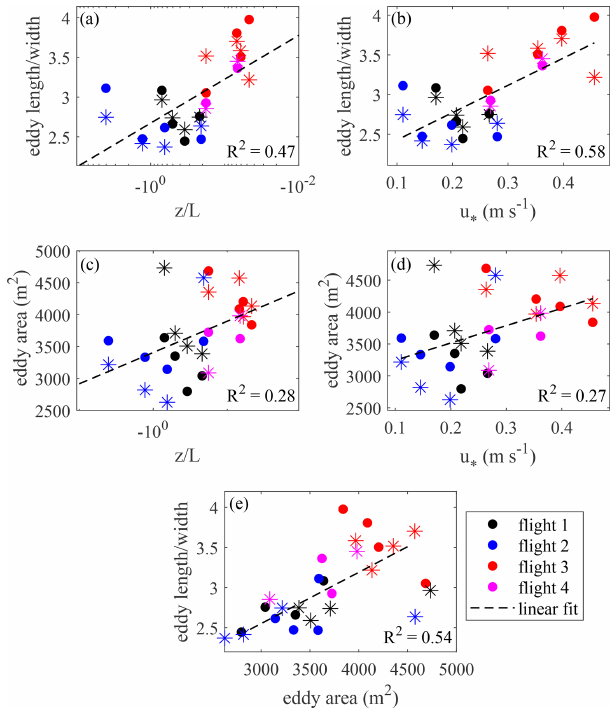
Figure 12. (a–d) Relationship between the 5min average properties of eddy thermal traces (mean area, length-to-width ratio) and the corresponding averages of z/L O and u ∗ ; (e) length-to-width ratio versus mean area. The * indicates eddy traces with positive mean T (cid:48) ; • indicates those with negative mean T (cid:48)